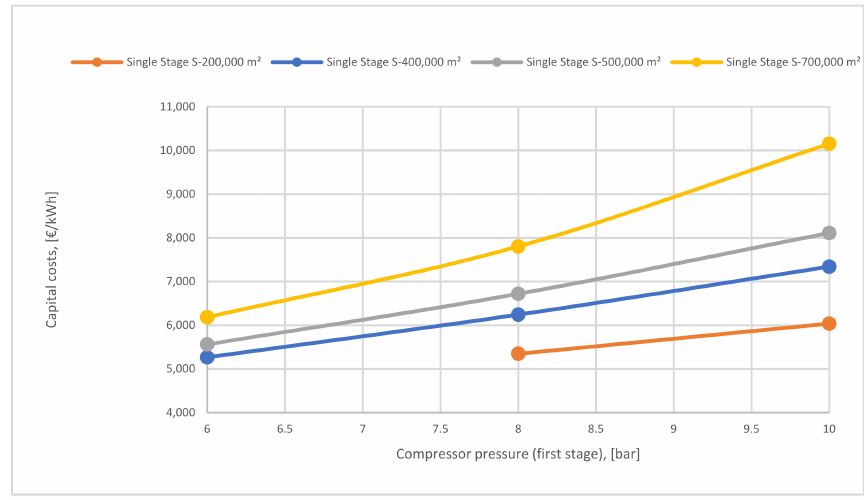
Figure 23. 1st compressor pressure effect on the capital cost at different surfaces area. The influence of SA 1 on CO 2 capture efficiency of one (with and without VP) and 2-stages of the membrane is shown in Figure 24. The case where the 1-single stage of the membrane with vacuum is used has the highest values of CO 2 capture efficiency due to the high-pressure difference across the membrane unit. At 400,000 m 2 of SA 1 , 1-stage (with vacuum) of membrane achieved almost 100% CO 2 capture efficiency. While, in the same point, CO 2 capture efficiency is less by around 6% and 13% for 1-stage (no vacuum) and 2-stages of the membrane, respectively.